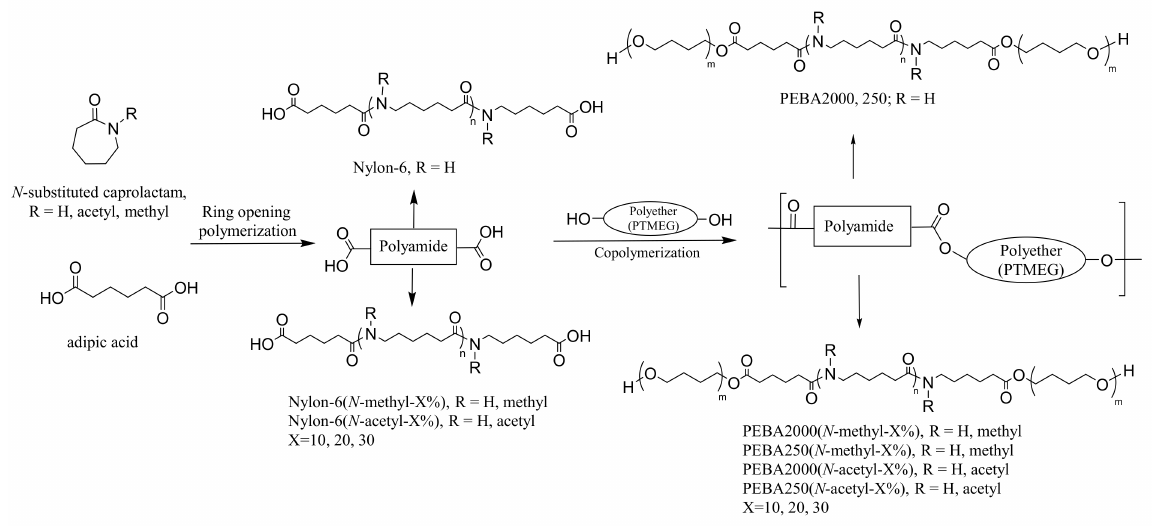
Figure 1. Synthesis route of N -substituted polyether- block